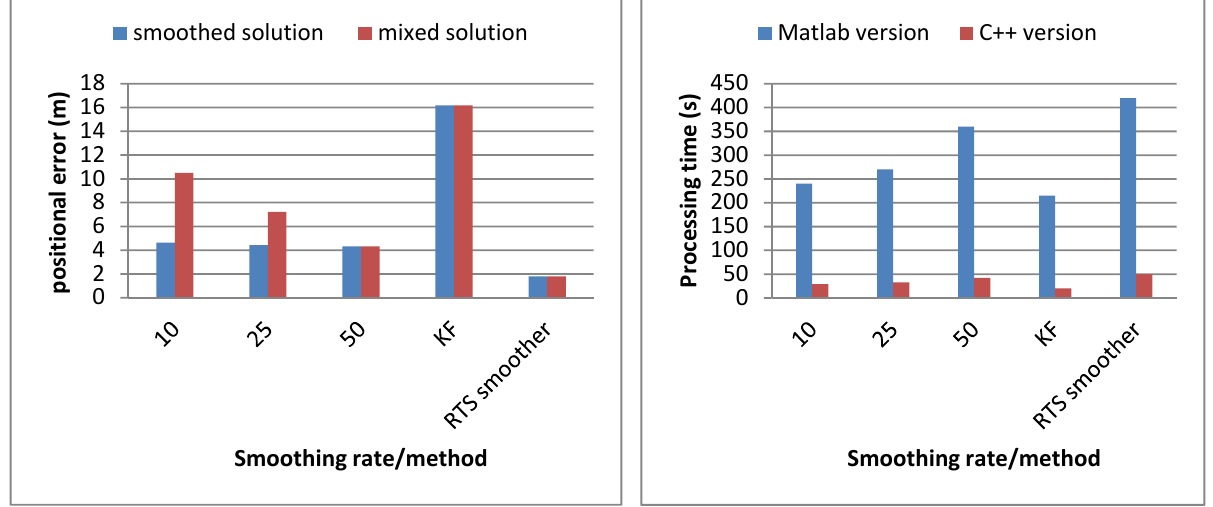
Figure 18. Relationship between smoothing rate and positional error and processing time. smoothed solution